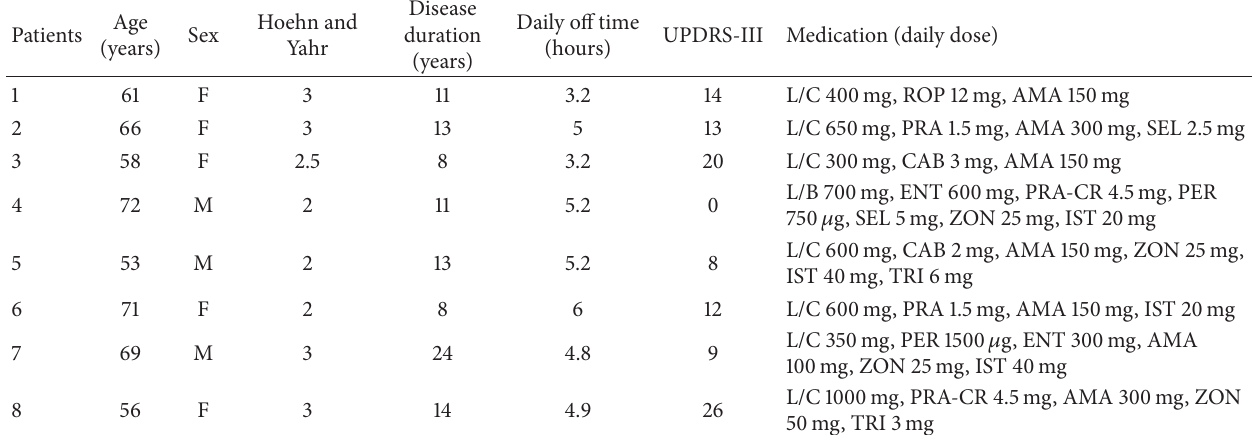
Table 1: Clinical characteristics of patients with Parkinson’s